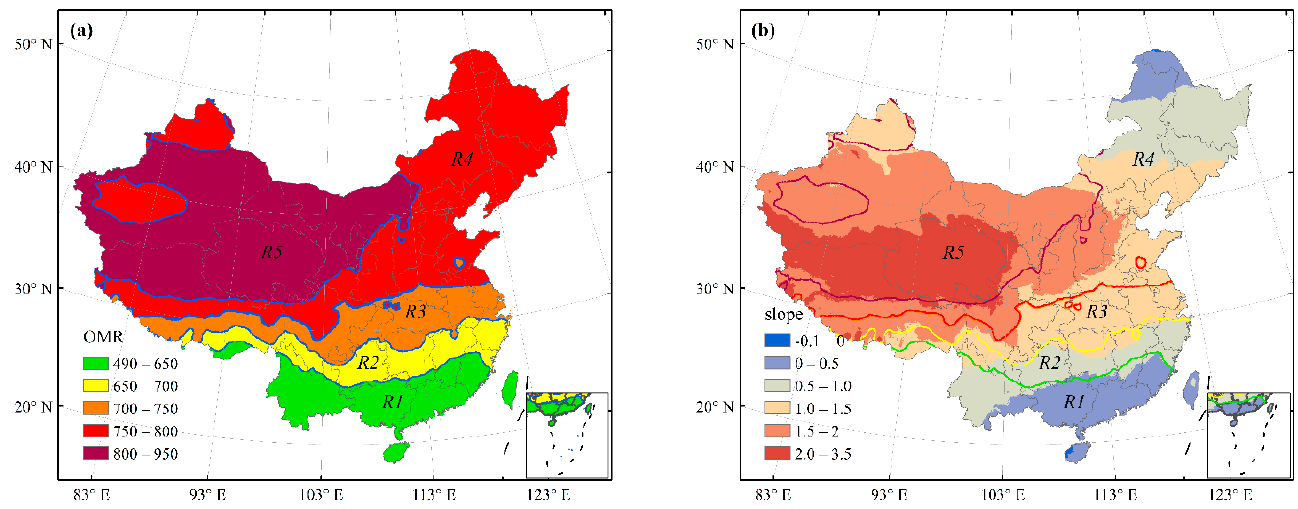
Figure 2. ( a ) The spatial distribution of OMR in the growing season from 1982 to 2020 and ( b ) the spatial distribution of the rate of OMR change. The colored lines from south to north refer to the contour lines of OMR values of 650, 700, 750 and 800 kg/kg, respectively. The author used the software of ArcGIS 10.5 to produce the figure.